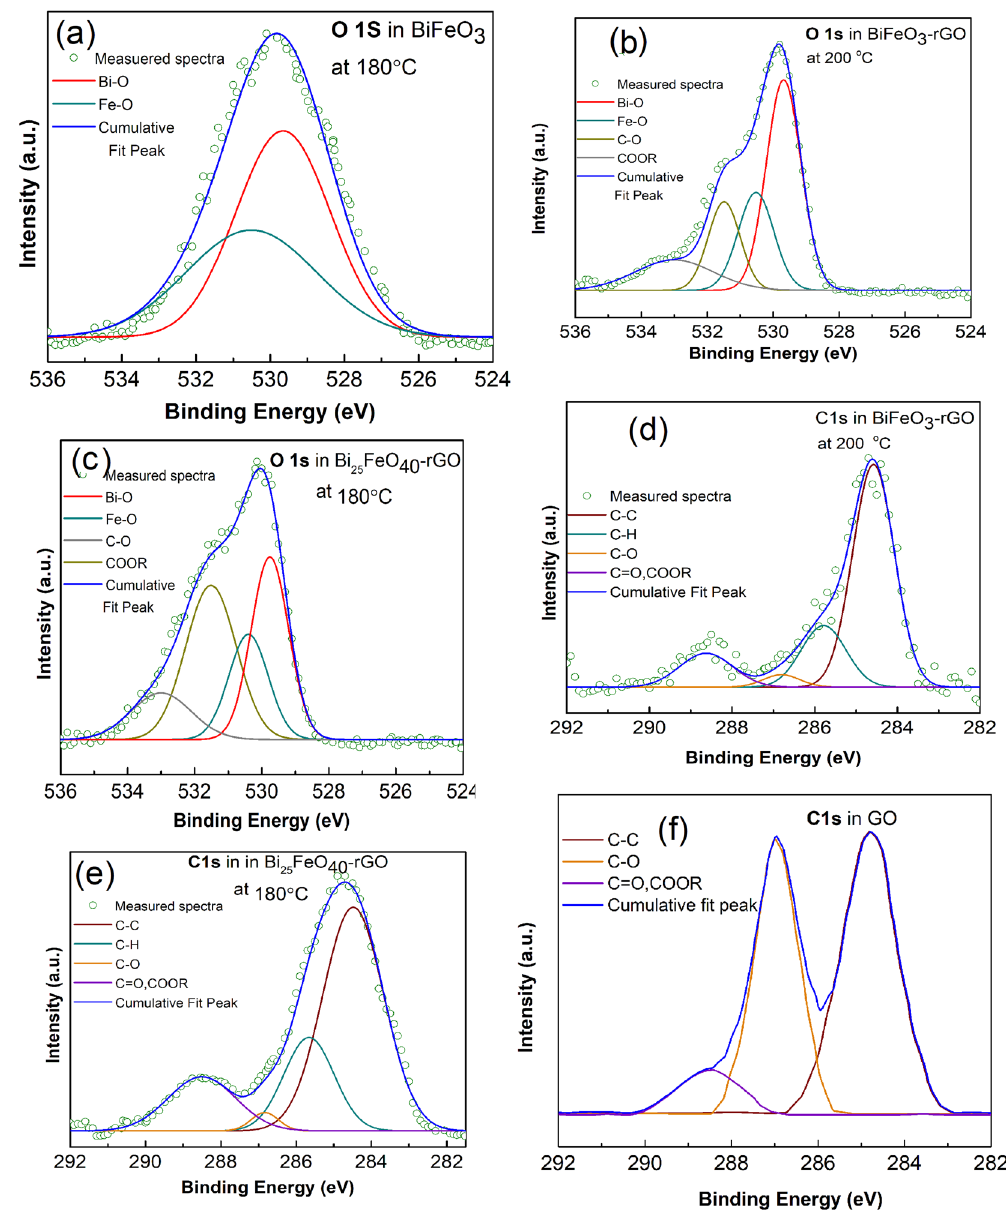
25 FeO 40 -rGO nanocomposite, and core level C 1s of ( d ) perovskite BiFeO 3 -rGO nanocomposite, ( e ) sillenite Bi 25 FeO 40 -rGO nanocomposite, and ( f )